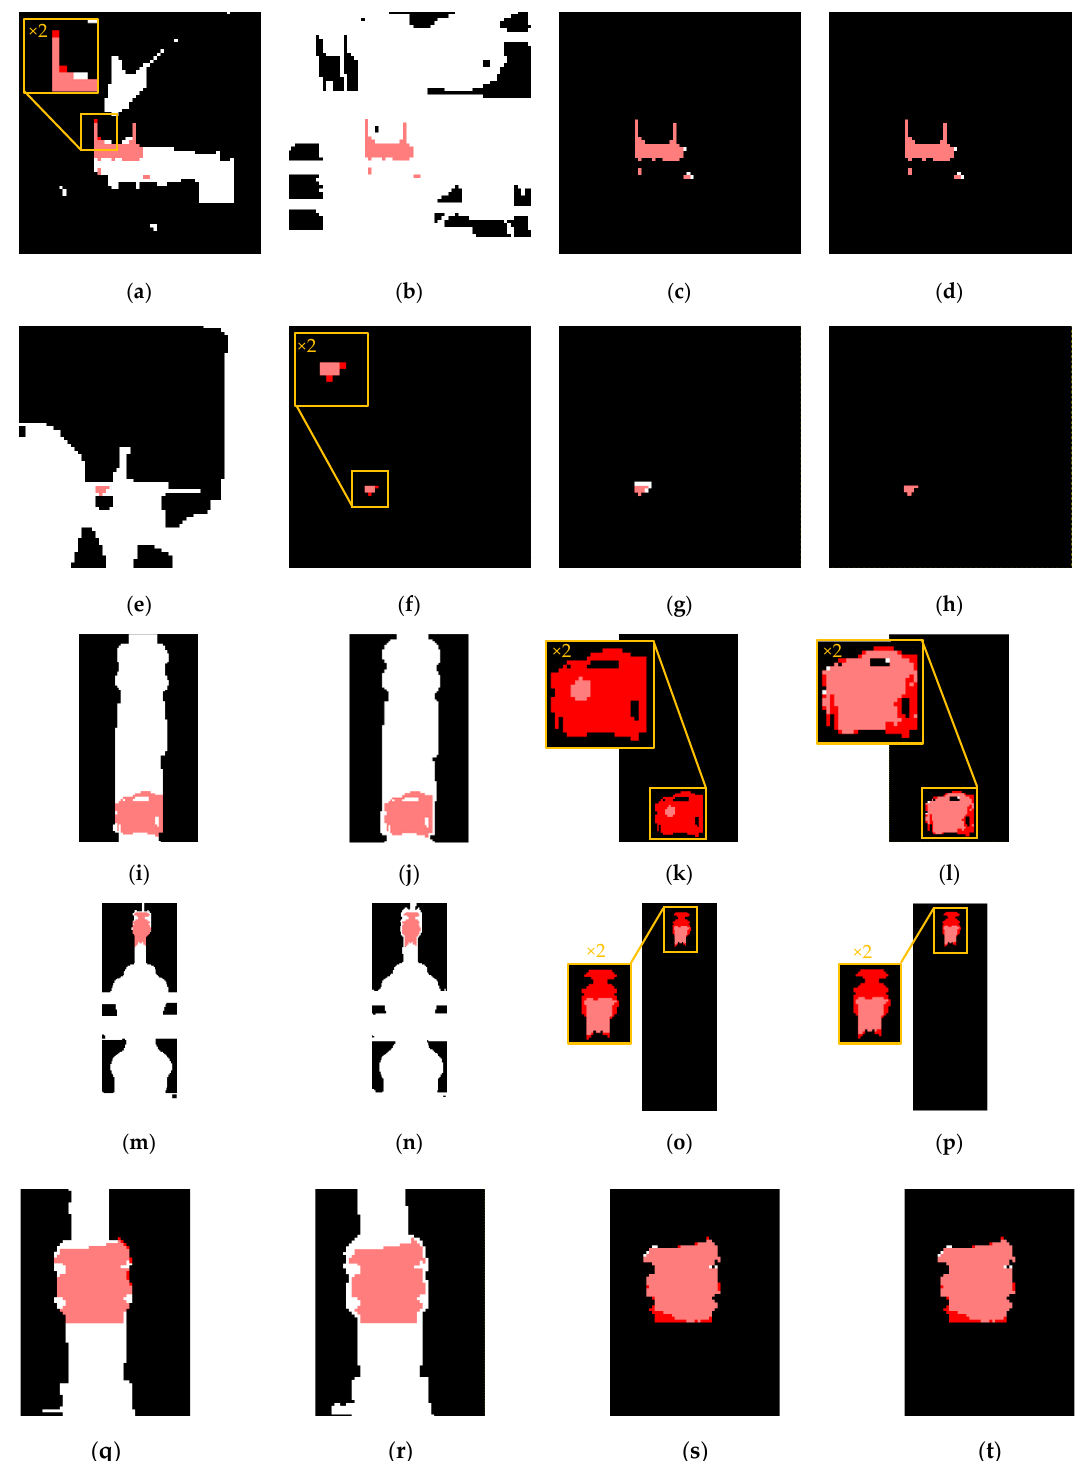
Figure 4. Results of automatic segmentation of IRTs through the methods, superimposed with the ground truth: ( a , e , i , m , q ) Otsu; ( b , f , j , n , r ) Histogram-Based Threshold; ( c , g , k , o , s ) Cluster K-means; ( d , h , l , p , t ) Fuzzy C-means.